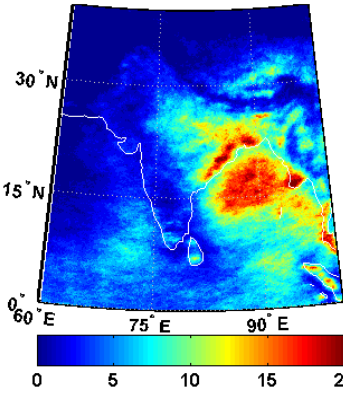
Fig. 3. The climatological distribution of deep convective clouds (with AVHRR channel 4 brightness temperatures < 220K) over the study area for the summer (JJAS) monsoon season. The occurrence frequencies are shown in percent.